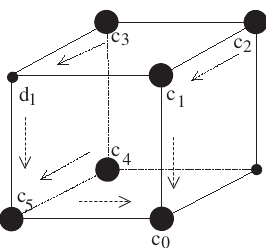
Figure 1. Configuration of the pointed 6-null homotopic of 1